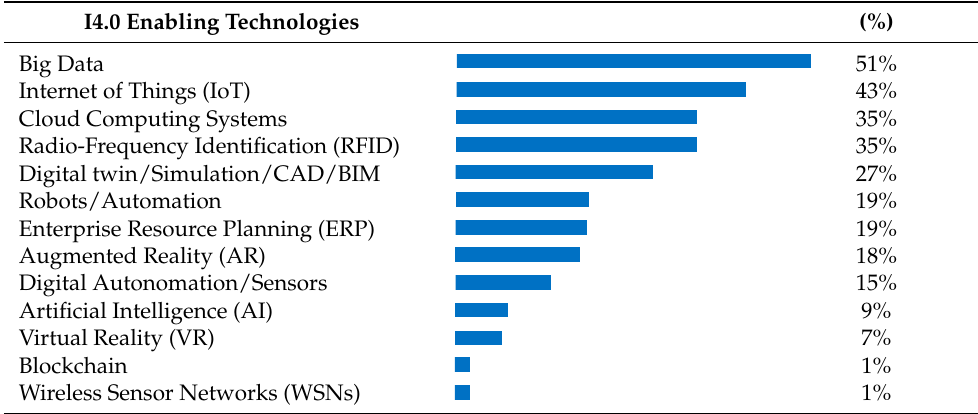
Table 4. List of technologies enabling I4.0 and LSS integration.